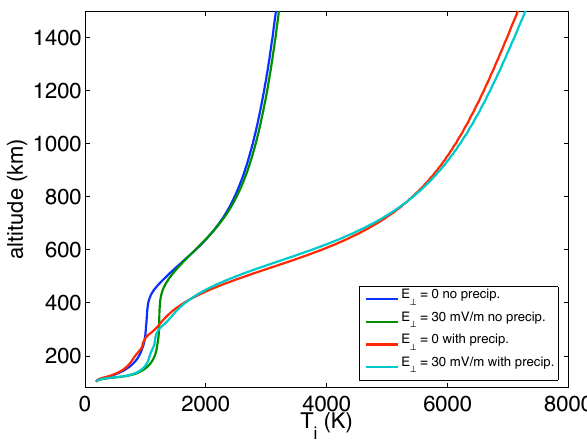
Fig. 9. Modelled ion temperature profiles with and without convec- tion and soft precipitation